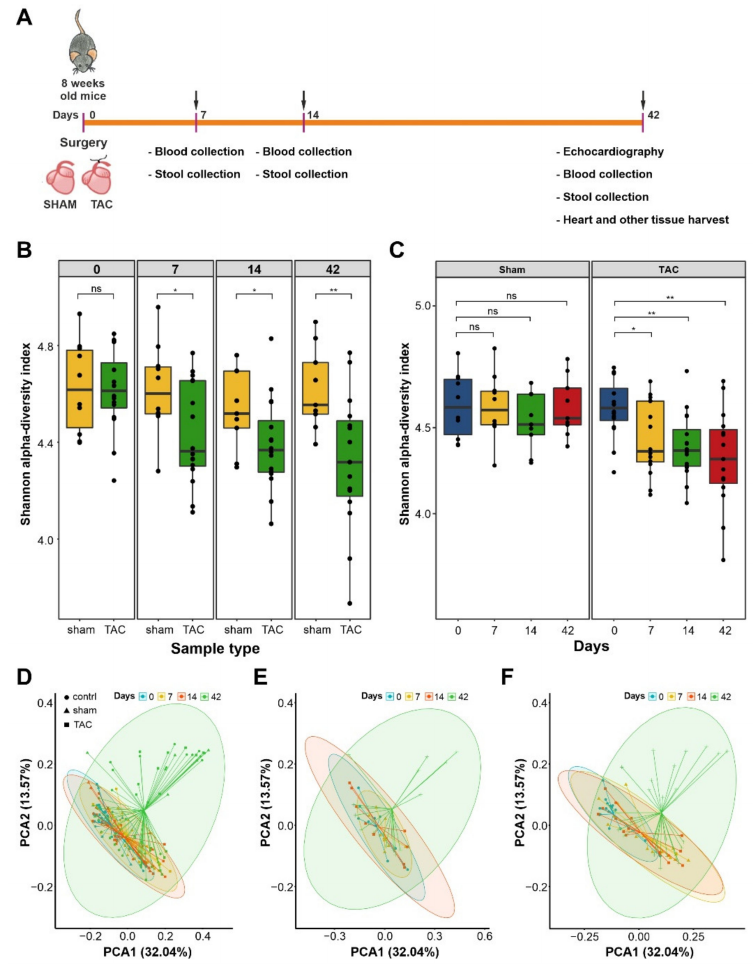
Figure 1. Diversity differences between Sham and TAC sample types. ( A ) Pictorial representation of the study plan. ( B ) Box plots for the Shannon alpha-diversity index in Sham and TAC samples at different time points. The box plot boxes indicate interquartile ranges (IQR), the black line indicates the median, whiskers extend till extreme values within 1.5 times the IQR, and black points outside whiskers are outliers. For the 1st- and 6th-week samples, Shannon index values with significant differences in the Sham and TAC samples are shown (*, **, and ns correspond to p ≤ 0.05, p ≤ 0.01, and not significant, respectively). ( n values are as follows: Sham day 0 = 10, day 7 = 10, day 14 = 9, day 42 = 9; TAC day 0 = 16, day 7 = 16, day 14 = 16, day 42 = 15). ( C ) Box plots for the Shannon alpha- diversity index within sample type (Sham and TAC) at different time points. Observed significant differences for each timepoint sample comparison with the 0th-day TAC samples. ( n values are as follows: Sham day 0 = 10, day 7 = 10, day 14 = 9, day 42 = 9; TAC day 0 = 16, day 7 = 16, day 14 = 16, day 42 = 15). ( D ) For different time points, separate clusters were observed in the PCoA plot for all sample types. For the 6th-week samples, distinct clusters were observed for the control, Sham, and TAC sample types (PERMANOVA p -value: 0.001, beta dispersion p -value: 1 × 10 − 4 ). ( n values are as follows: control day 0 = 12, day 7 = 12, day 14 = 12, day 42 = 12; Sham day 0 = 10, day 7 = 10, day 14 = 9, day 42 = 9; TAC day 0 = 16, day 7 = 16, day 14 = 16, day 42 = 15). ( E ) PCoA plot of Sham samples at different time points. The 6th-week samples formed a separate cluster compared to other timepoint samples for the Sham sample type. (PERMANOVA p -value: 0.377, beta dispersion p -value: 0.3875) ( n values are as follows: day 0 = 10, day 7 = 10, day 14 = 9, day 42 = 9). ( F ) PCoA analysis of TAC samples at different time points. The 6th-week samples formed a distinct cluster as compared to other time point data of TAC samples with large variations. (PERMANOVA p -value: 0.001, beta dispersion p -value: 1 × 10 − 4 ) ( n values are as follows: day 0 = 16, day 7 = 16, day 14 = 16, day 42 =